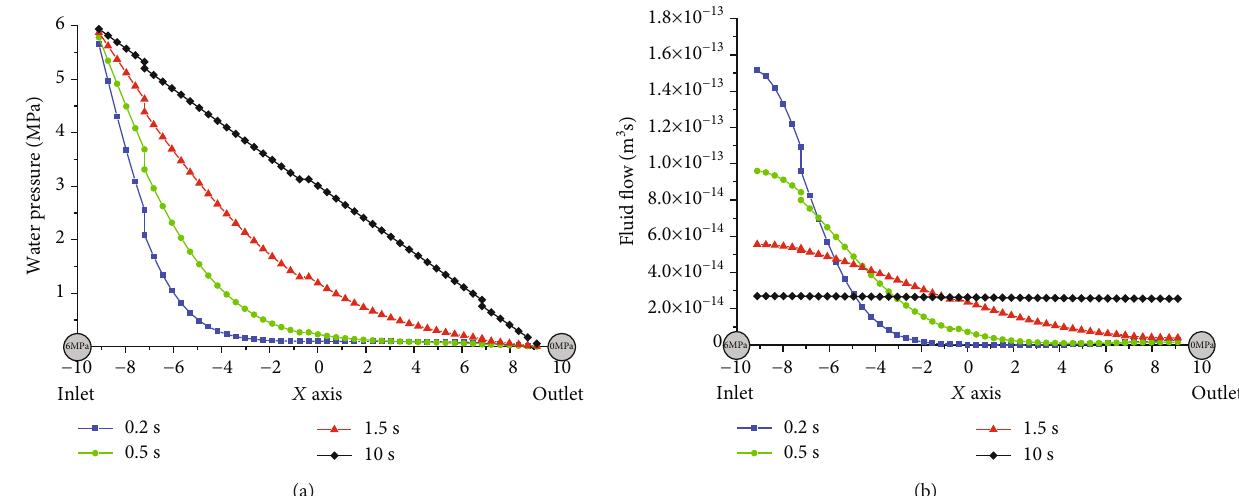
Figure 7: Fluid pressure and fl ow variation in single fracture at di ff erent times: (a) time- fl uid pressure curve and (b) time- fl uid fl ow